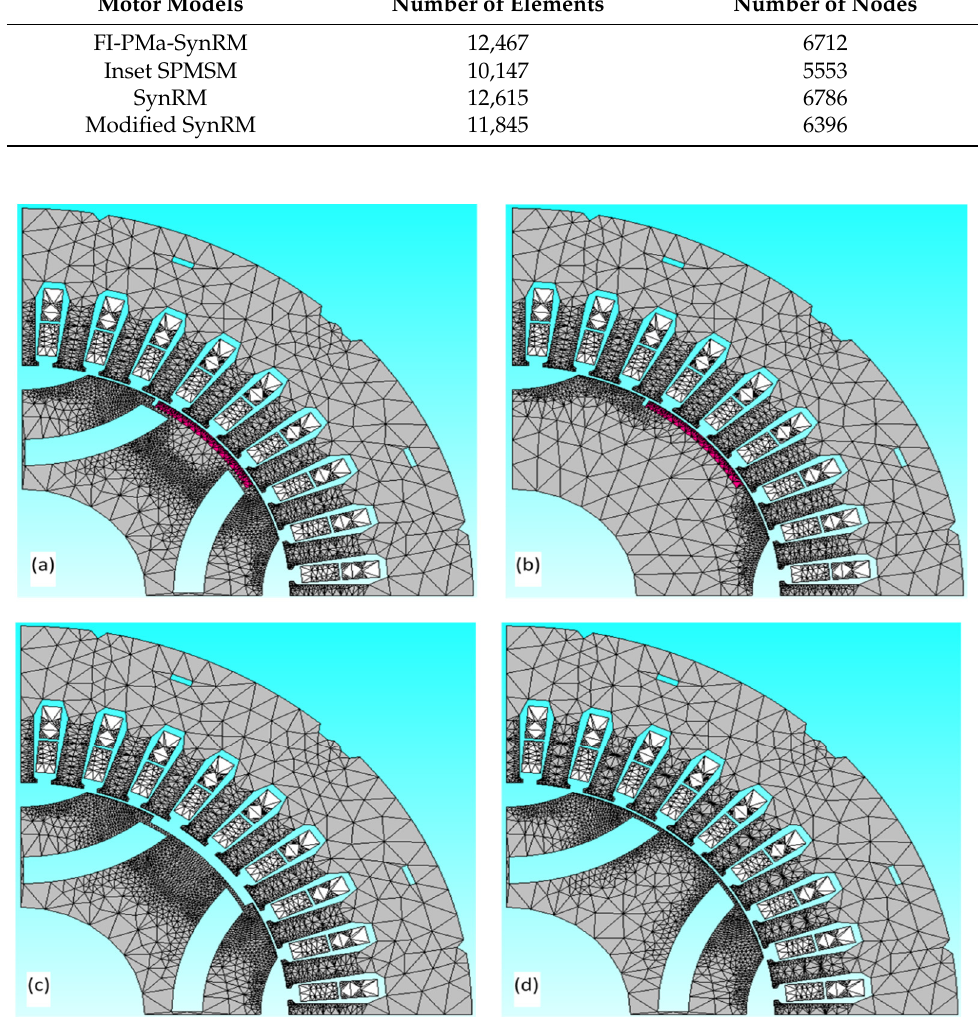
Table A2. Mesh information of considered four models.